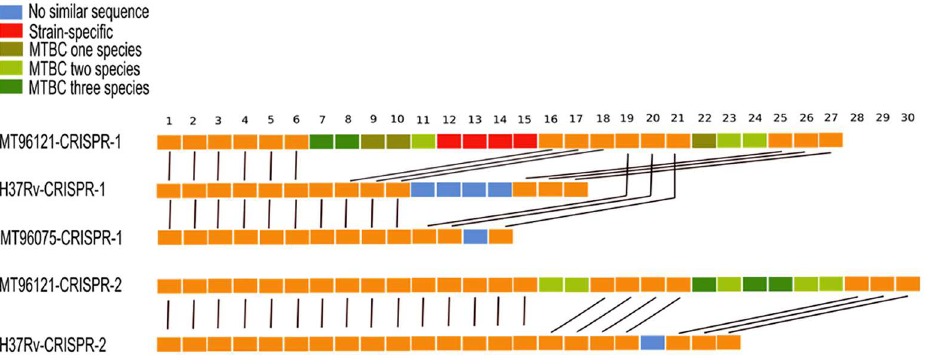
Fig 2. CRISPR spacer rearrangements in Manila family 96121, Beijing family 96075,and H37Rv. Green highlightsspacers conservedwith other MTBC species but lost in modern Beijingfamily isolate 96075 and H37Rv. Red highlightsspacers specific in Manilafamily isolate 96121. Blue highlights spacers present in H37Rv but absent in Manila family isolate 96121and Beijingfamily isolate96075.